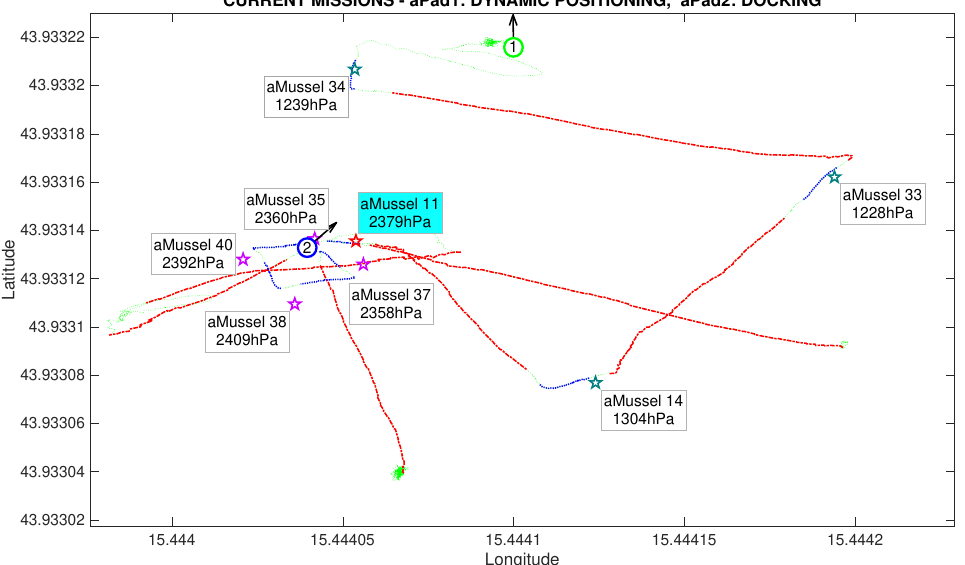
Figure 18. Outlier validation completed in the Anoxia scenario experiment results from the deployment phase, reconstructed and replayed from recorded vehicle data—Biograd na Moru